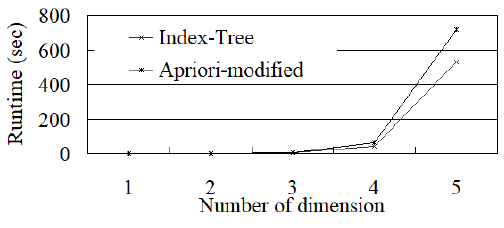
Fig. 16 Runtime vs. number of dimensions ( d = 10K, n = 10, m = 40%, s = 30%).